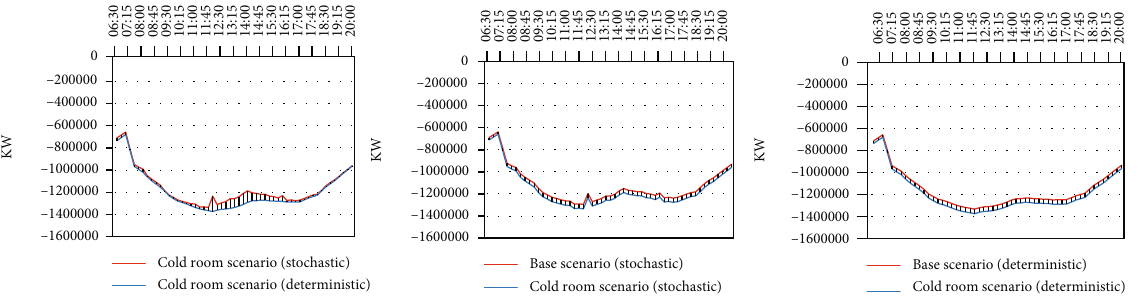
Figure 21: Di ff erent modes in the cold room scenario (day).